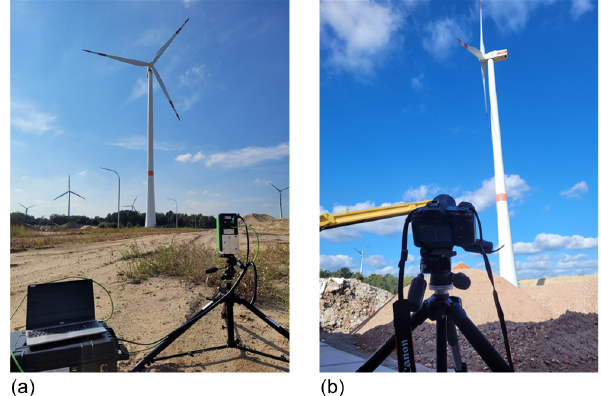
Table 1. Wind turbine characteristics.